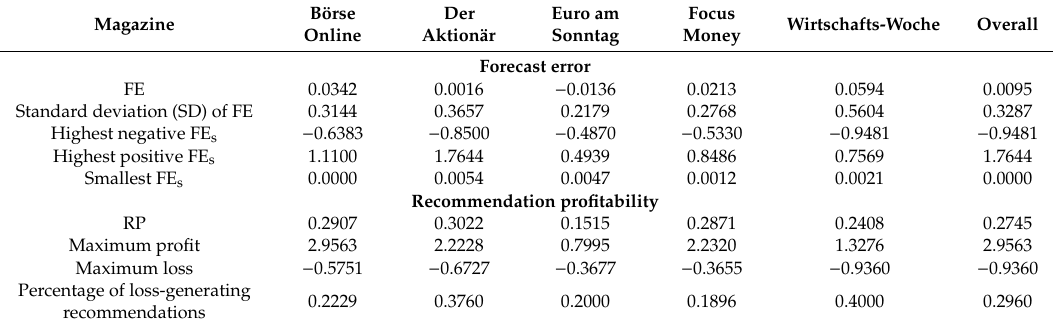
Table 1. Results for each